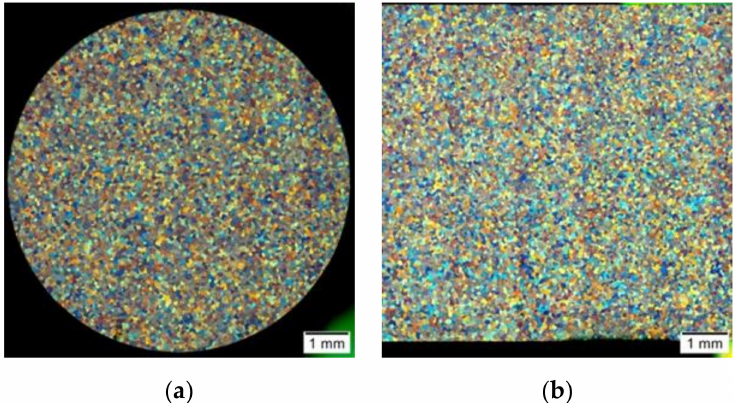
Figure 16. Microstructure of the 5019 aluminium alloy in initial state, after the homogenisation process (before the deformation process): ( a ) cross-section; ( b ) longitudinal section.